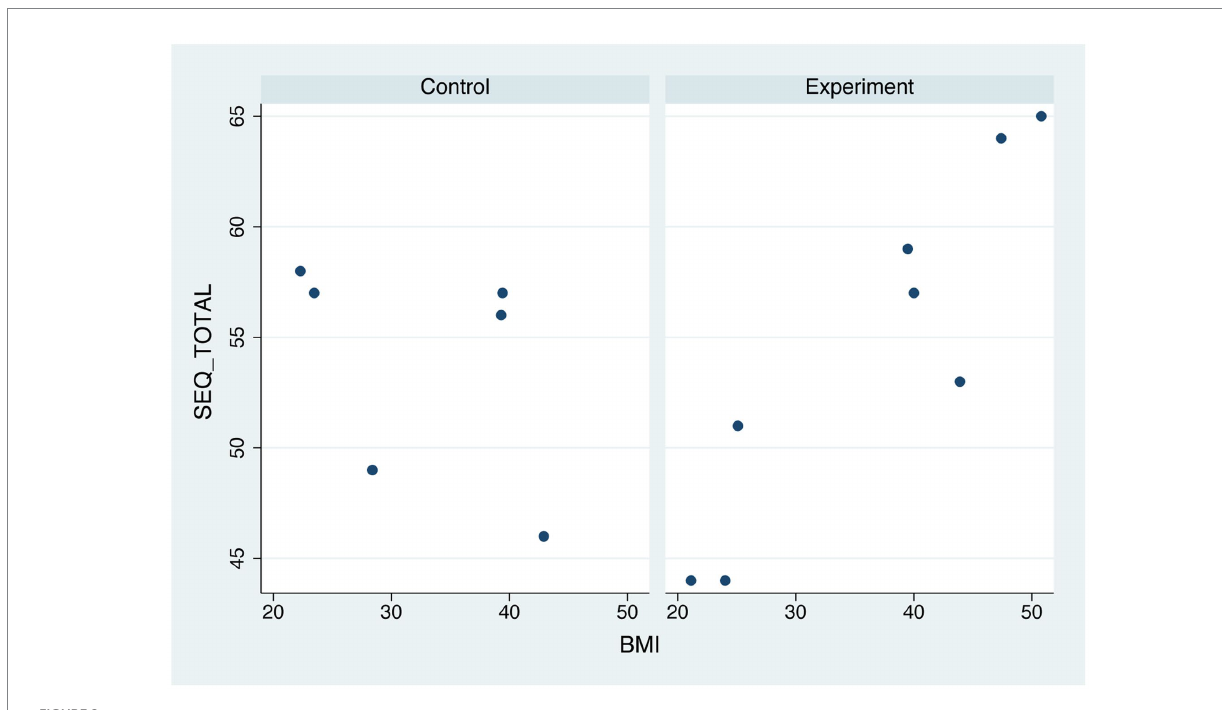
FIGURE 2 Relationship between body mass index and suitability evaluation questionnaire scores separately distributed in normal weight participants and patients.